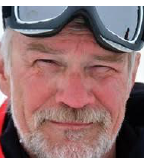
Figure 1. Professor Wilfried Korth († 2019).